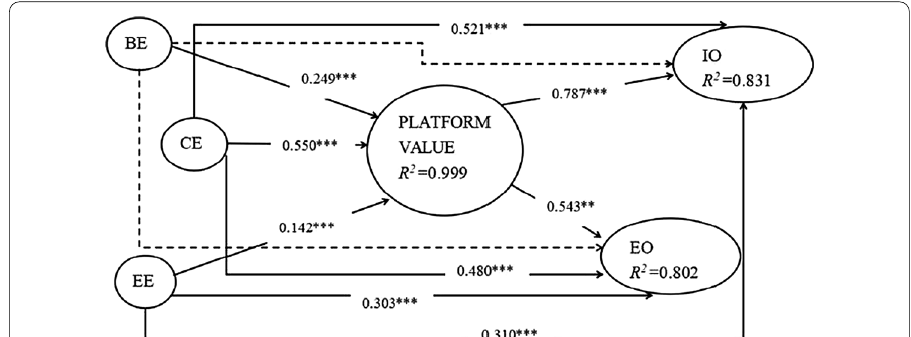
Fig. 3 Structural model analysis. **p < 0.05; ***p < 0.01